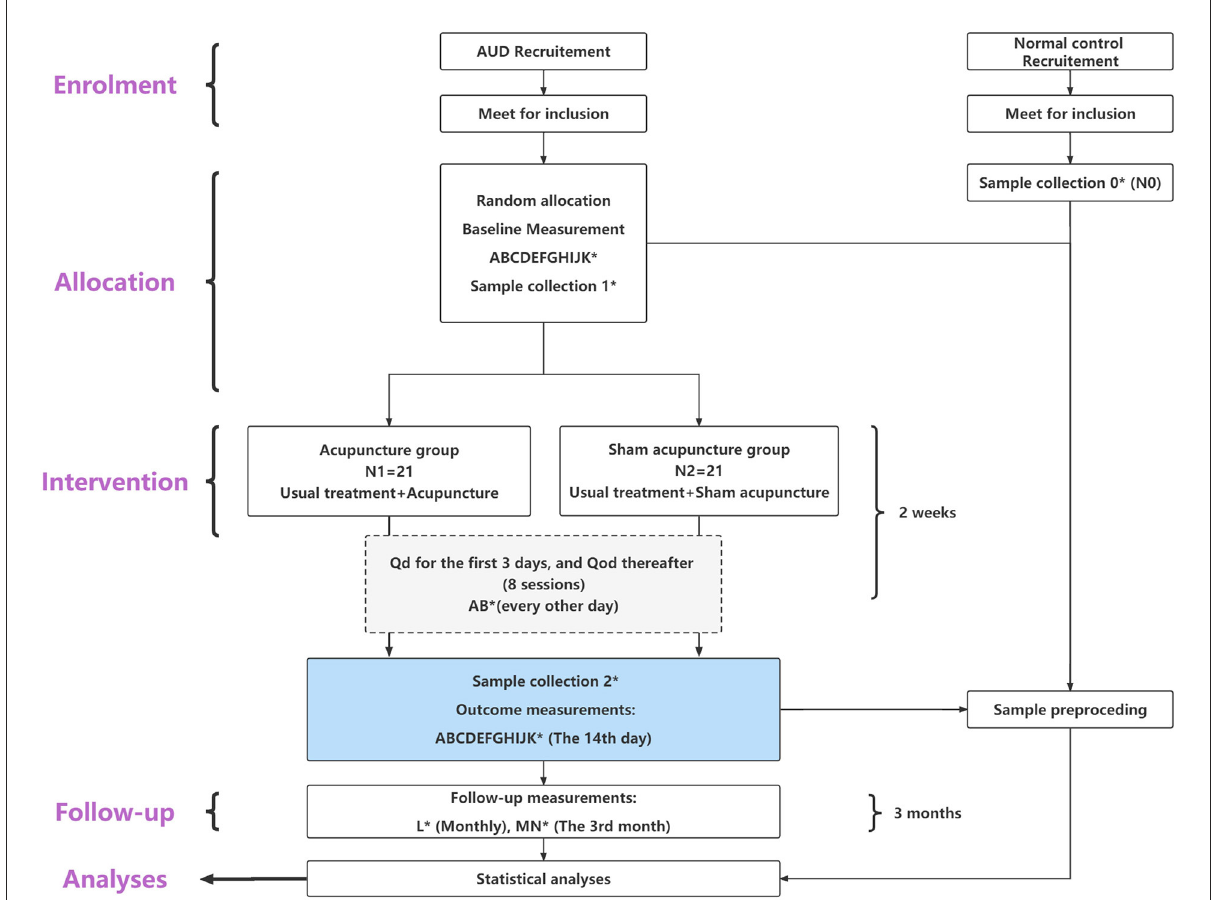
FIGURE1 Flow diagram of the study process. * Sample collection 0, 1, 2 means to collect 10 fecal samples from each patient group (N1 and N2) at baseline and at the end of the last intervention; additionally, to collect 10 fecal samples from the health control group (N0). (A–N) means the 14 measurement tools applied in this study, distributed in specific study phases. (A) CIWA-Ar, Clinical institute alcohol withdrawal syndrome scale. (B) abs-VAS, Abstinence visual analog-rating scale. (C) AUQ, Alcohol urge questionnaire. (D) cue-VAS, Cue-related visual analog-rating scale. (E) BDI-II, Beck depression inventory II. (F) BAI, Beck anxiety inventory. (G) PSQI, Pittsburgh sleep quality index. (H) MFS, Mental fatigue scale. (I) GSES, General self-efficacy scale. (J) Gastrointestinal symptom rating scale. (K) QOL-DA, Quality of life scale for patients with